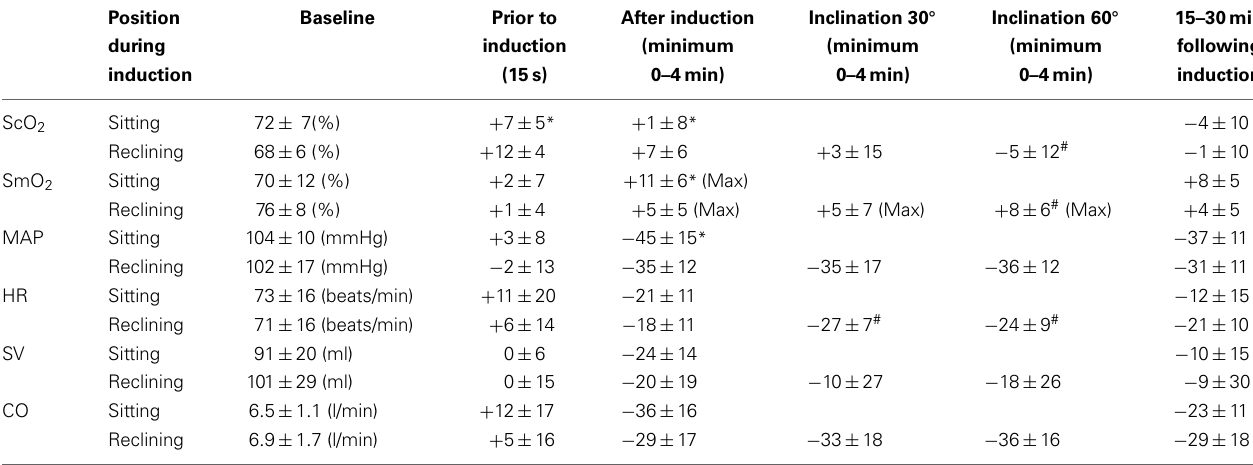
represent the minimum (SmO 2 : maximum) of 15s averages. *Sitting vs. reclining; p < 0.05. # Different from the minimum value after induction; p <